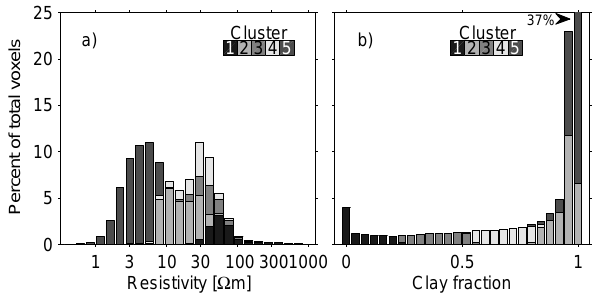
Figure 8. Histograms of (a) logarithmic geophysical resistivity val- ues and (b) clay-fraction values. Cluster memberships of the val- ues are identified by shades of grey and the histograms thus show how resistivity values and clay-fraction values are represented in the clusters. The histograms are shown as percentage of total number of data